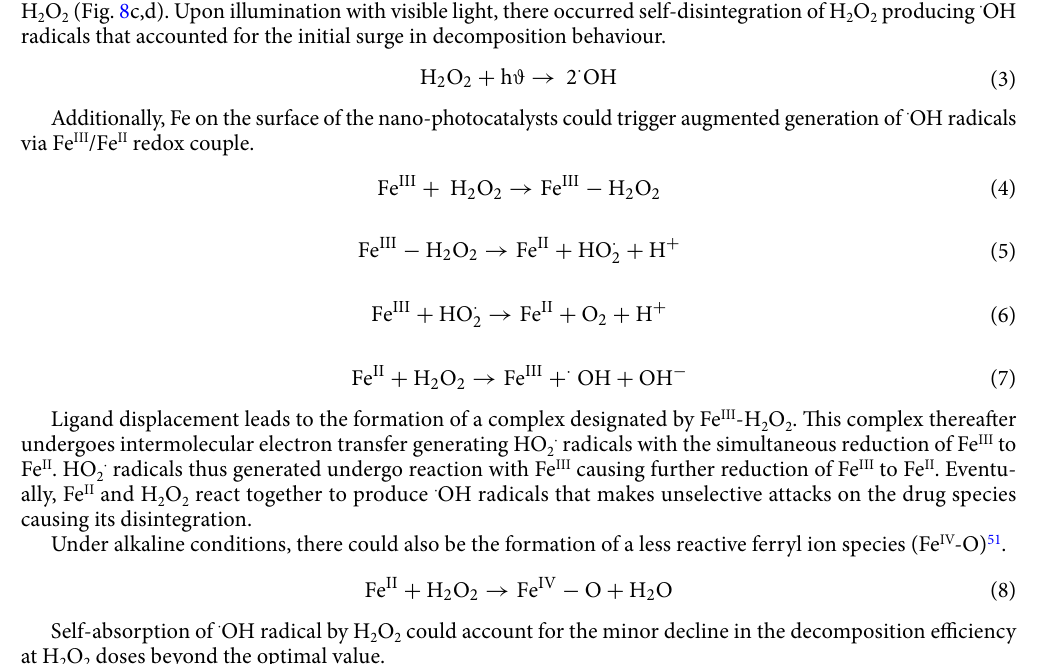
Performances of different photocatalysts. Figure 8a and Table 6 display photocatalytic performances of differ- ent photocatalysts while Fig. 8b represents the corresponding photodegradation kinetics. Photolysis carried out in absence of catalysts showed no appreciable decomposition of the pharmaceutical. The pristine samples also showed inferior decomposition capacities. Pristine In 2 O 3 could barely affect appreciable photodecomposi- tion of esomeprazole. Pristine MoS 2 brought about ~ 16.43 ± 2.01% of esomeprazole decomposition at pseudo- first order velocity constant of ~ 0.00054 min −1 . The binary nanohybrid of In 2 O 3 /Fe 3 O 4 attained ~ 43.26 ± 1.51% esomeprazole decomposition obeying pseudo-first order kinetics with a velocity constant of ~ 0.01503 min −1 . Esomeprazole photodecomposition over In 2 O 3 /MoS 2 /Fe 3 O 4 was considerably remarkable as the nano-scale